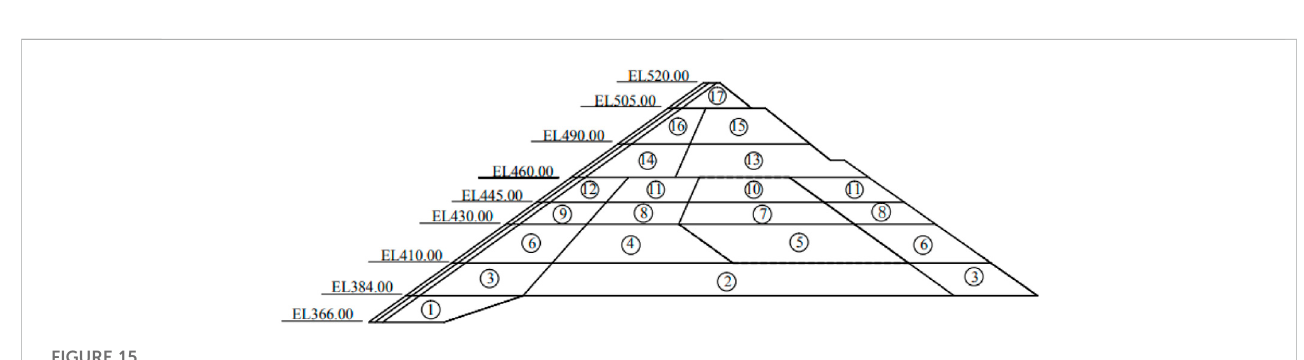
range, the cracks in cushion area, the voids and cracks in the panel and the extrusion failure of the panel concrete are rarely found in the general dam. The monitoring and calculation values of the dam